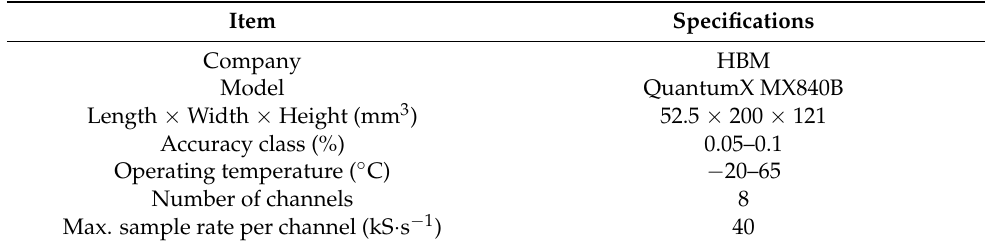
Figure 3. Data measurement system and data flow of the electric AWD tractor. Table 2. Specifications of DAQ used in this